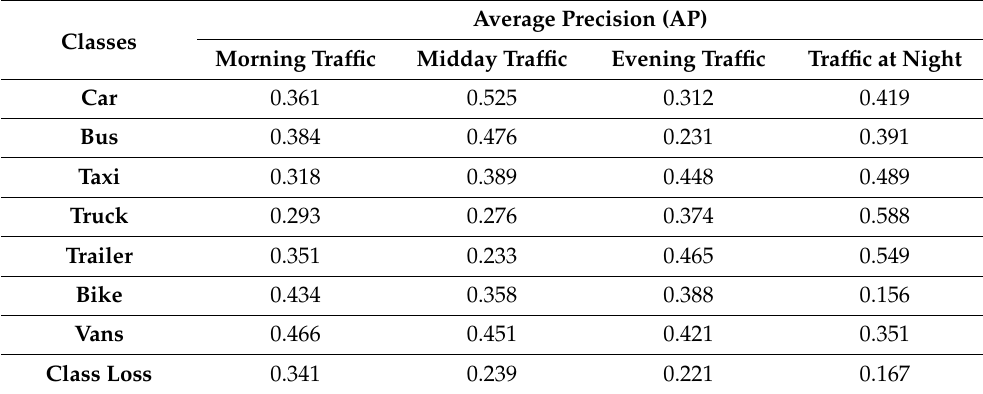
Table 7. Traffic analysis and classification of vehicles depending on the time of day, the hypothesis treated at a simulative